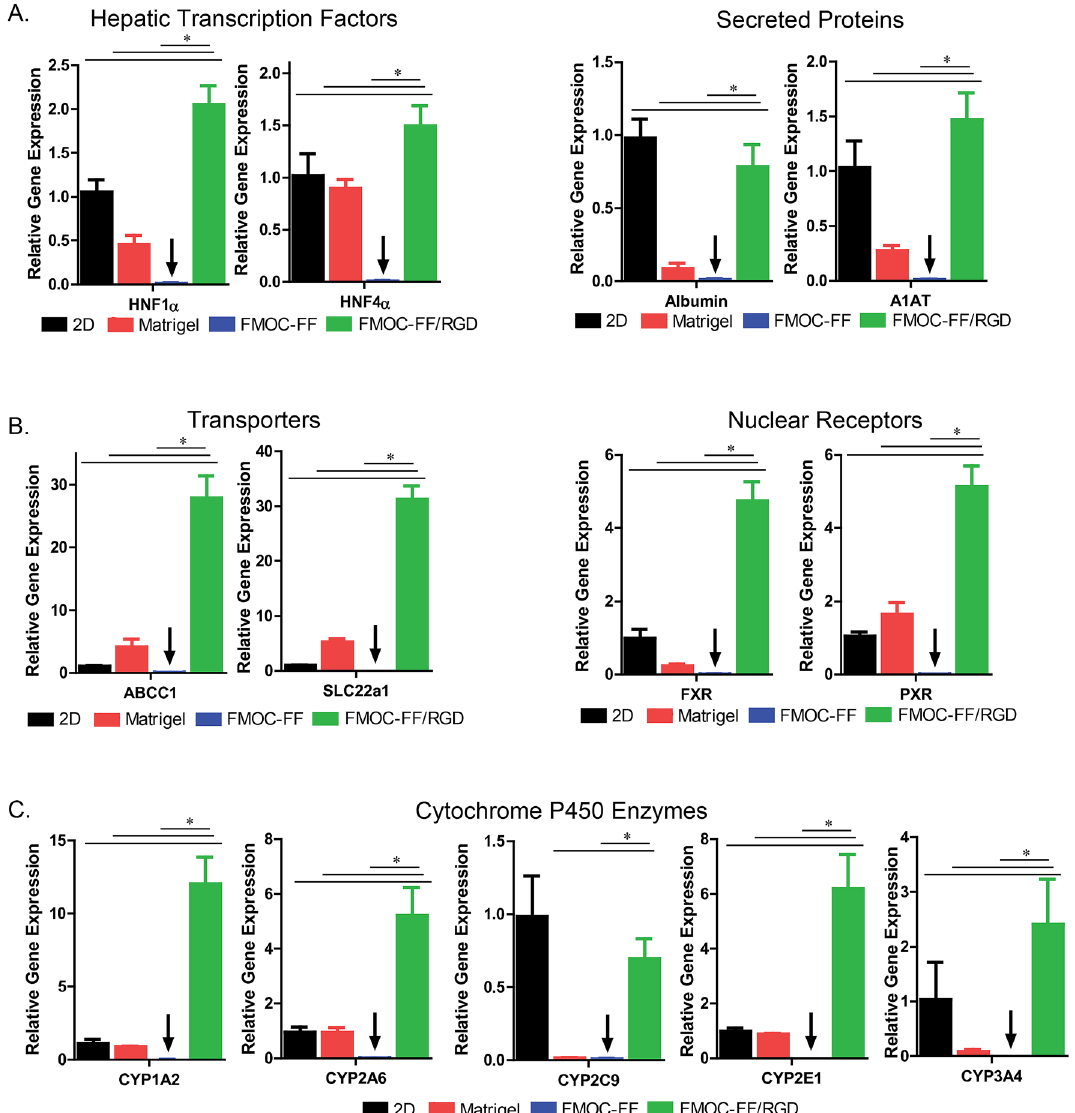
Figure 3. Relative expression of hepatocyte-specific genes in primary hepatocyte cells at day 14 of culture in hydrogel constructs (18 days after initial cell aggregation) Fmoc-FF, Fmoc-FF/RGD, Matrigel control and 2D micropatterned control (and as control reference). Tested genes include hepatic transcription factors HNF1α and HNF4α, secreted proteins albumin and A1AT, transporters ABCC1 and SLC22a1, nuclear receptors FXR and PXR and CYP P450 enzymes 1A2, 2A6, 2C9, 2E1 and 3A4. (*designates P < 0.05). N = 3 independent biological replicates. PowerPoint Professional Plus 2013 and Graphpad Version 6.0 was used to make the